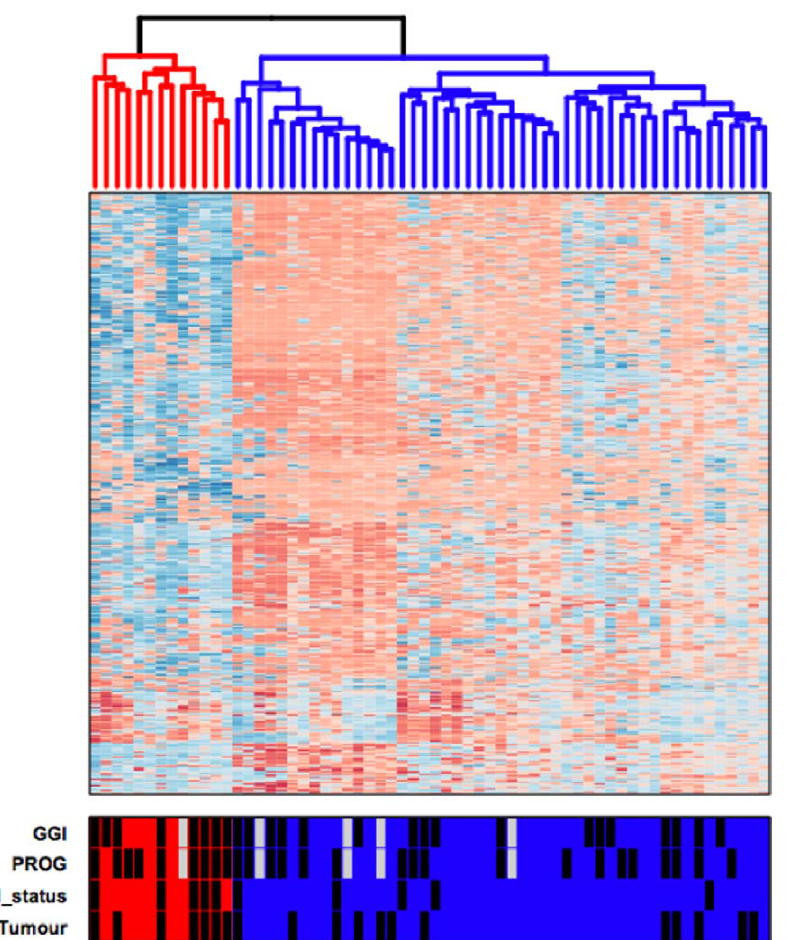
Figure 3. Hierarchical clustering of methylation values ( b ) from 500 CpG loci from 62 breast tumor samples. Columns represent samples; rows represent CpG loci. Color represents methylation level b from 0 to 1 as per color bar (red = low methylation level; blue = high methylation level). Samples separated into two distinct groups: a high b group consisting of 13 breast tumor samples (red dendrogram) and a low b group consisting of 49 breast tumor samples (blue dendrogram). Bottom horizontal bar indicates the distribution of samples according to the genomic grade index of Sotirou et al. [26] (black fill = grade 3, no fill = grade 1, grey fill = unknown), the 70-gene prognostic signature of van ’t Veer et al. [25] (black fill = poor prognosis, no fill = good prognosis, grey fill = unknown), M status (black fill = positive, no fill = negative) and tumor subtype (black fill = IBC, no fill = non-IBC).